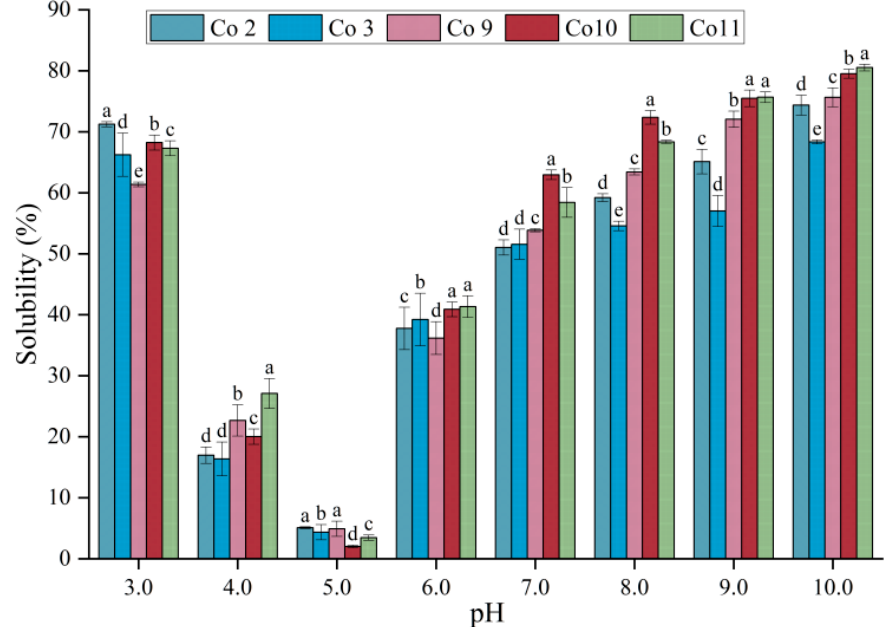
Figure 3. Solubility of Co prepared under different extraction pH conditions. Note: Different letters with the same pH indicate that there is a significant difference between samples ( p < 0.05).